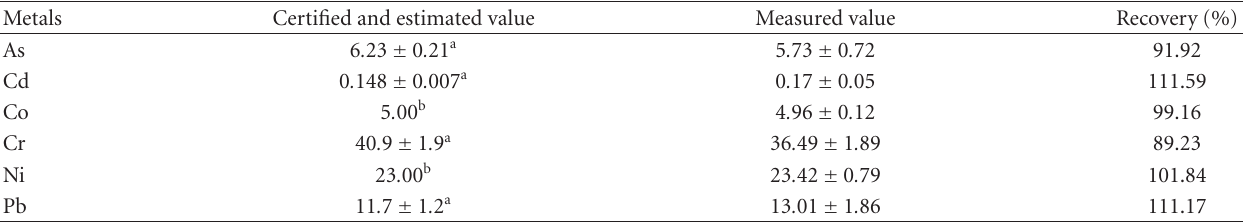
Table 3: Average concentration (mg/kg) of metals in sediment analysis obtained from three replicates of the standard reference materials NIST, SRM 1646 (estuarine sediment).